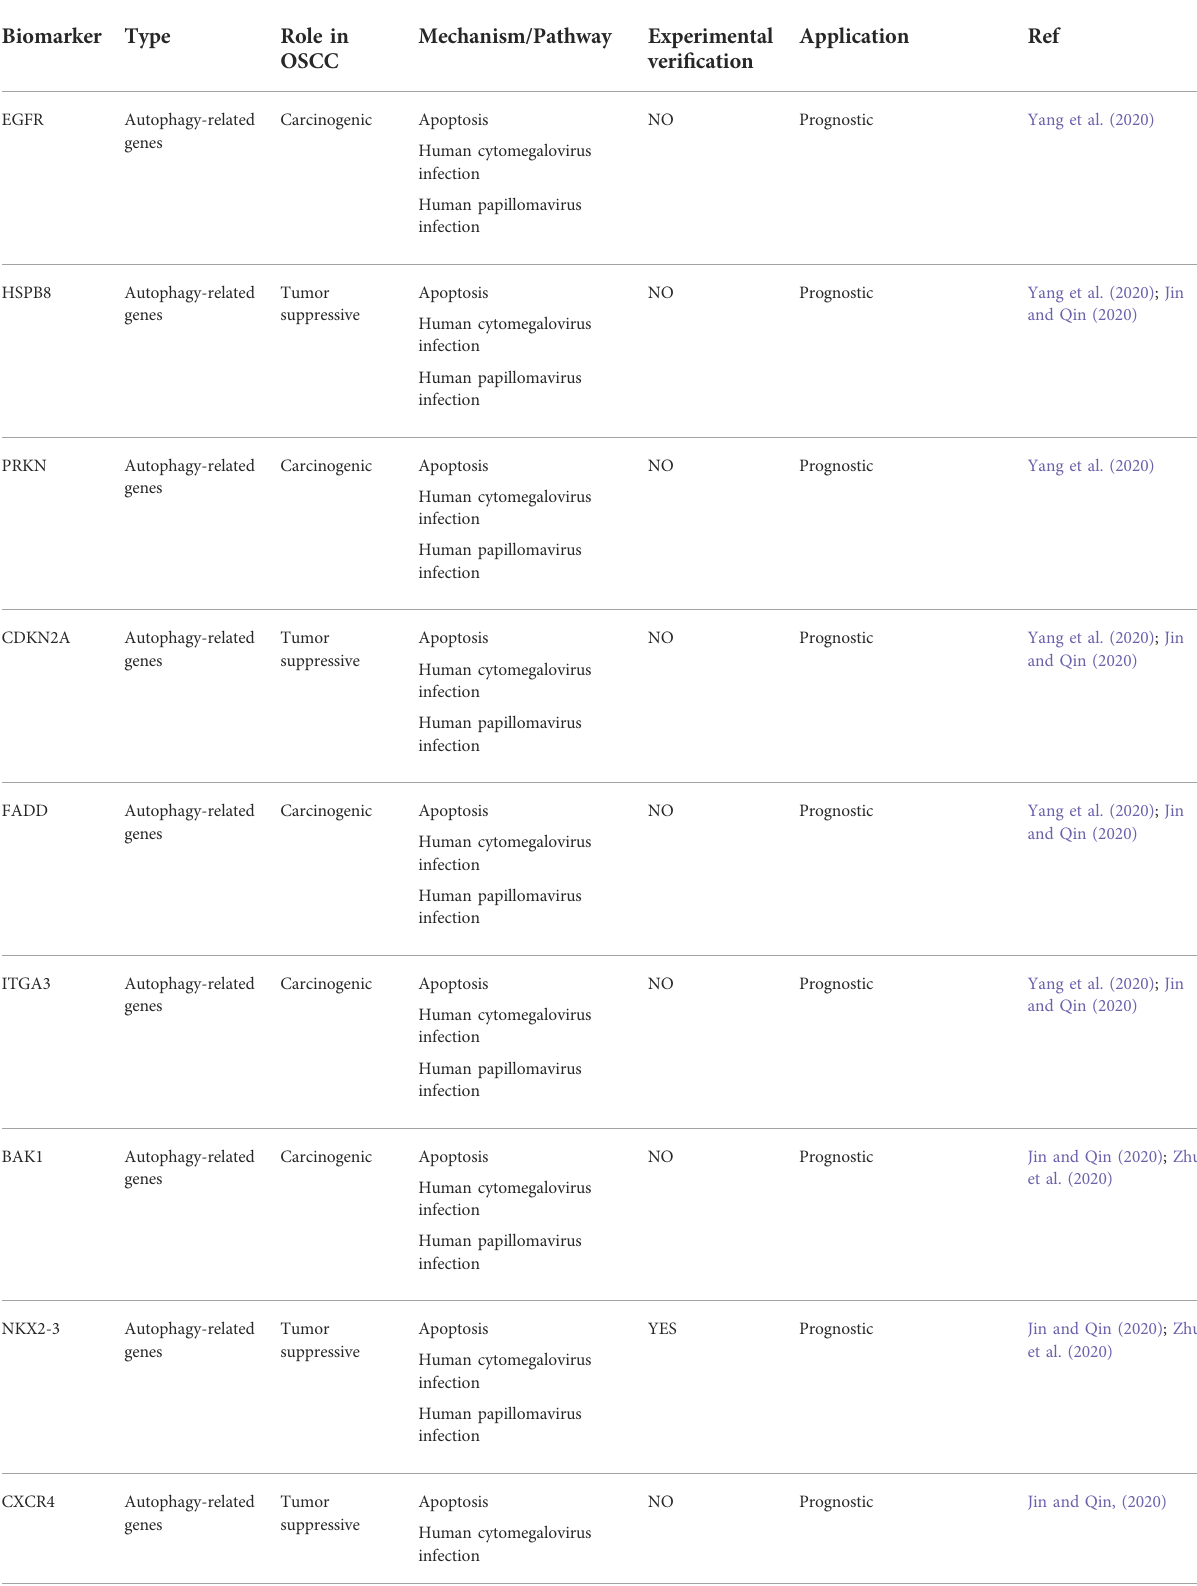
TABLE.1 Autophagy-related biomarkers in